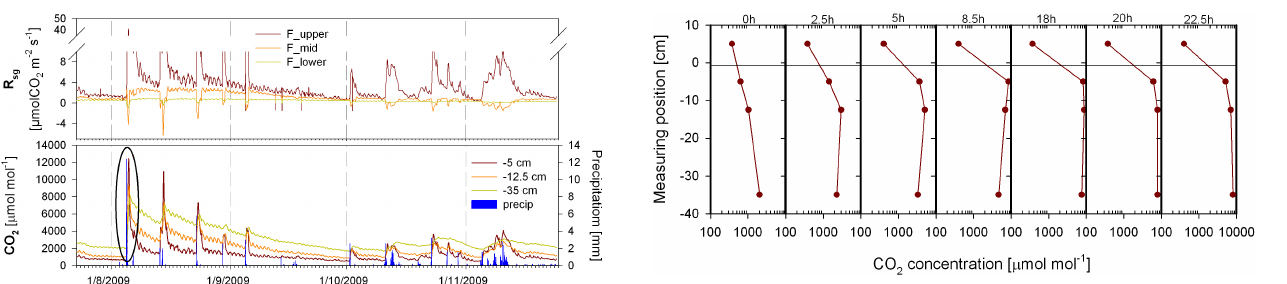
Fig. 9. Time course of soil respiration rates at three soil depths (see Table 2.) during drought in summer and autumn recovery (down- ward fluxes have negative signs, upper graph), CO 2 concentration within the soil profile at 5, 12.5 and 35cm below ground, respec- tively, and course of precipitation events (lower graph).